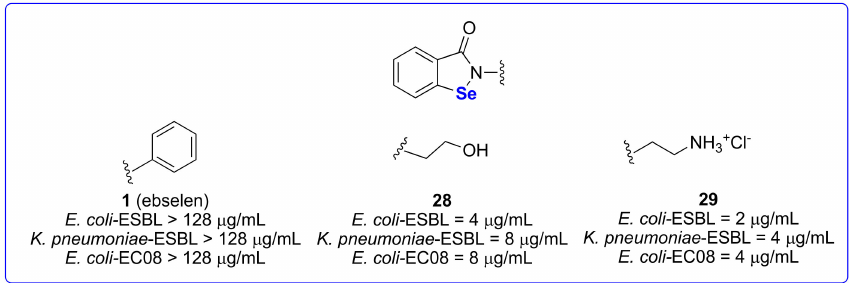
Figure 4. Hydrophilic ebselen analogues endowed with anti-Gram-negative bacteria